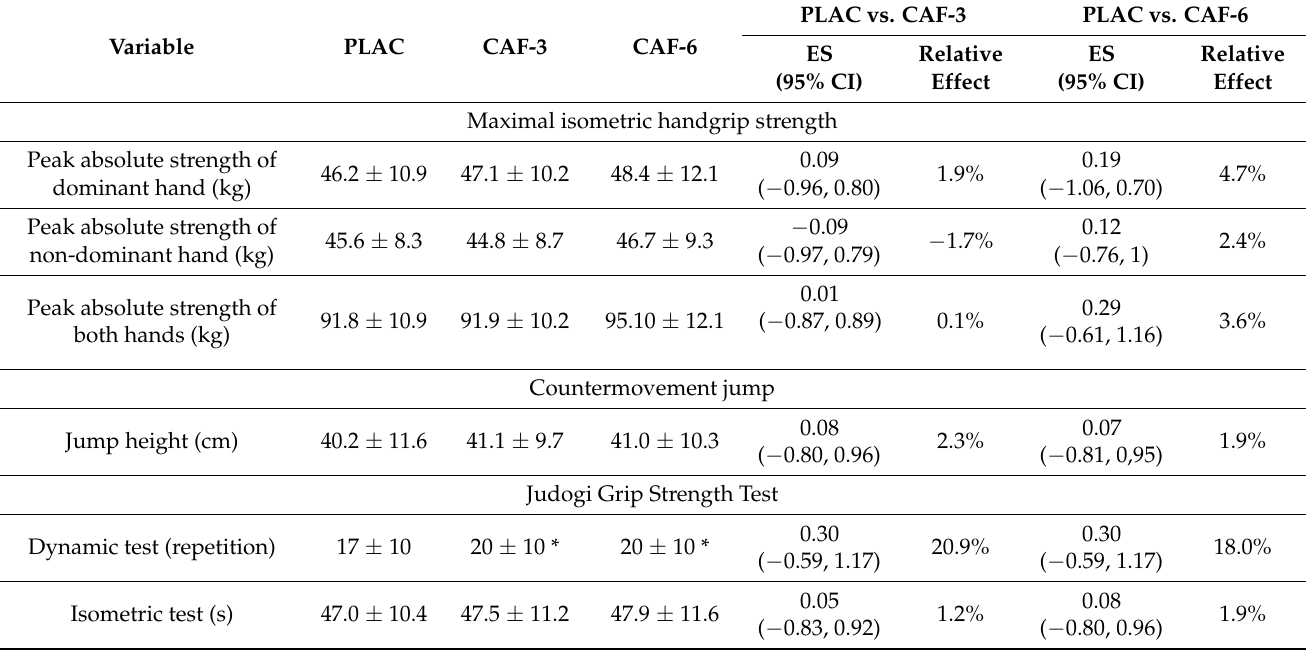
Table 3. Results of the effects of caffeine on the exercise performance outcomes.